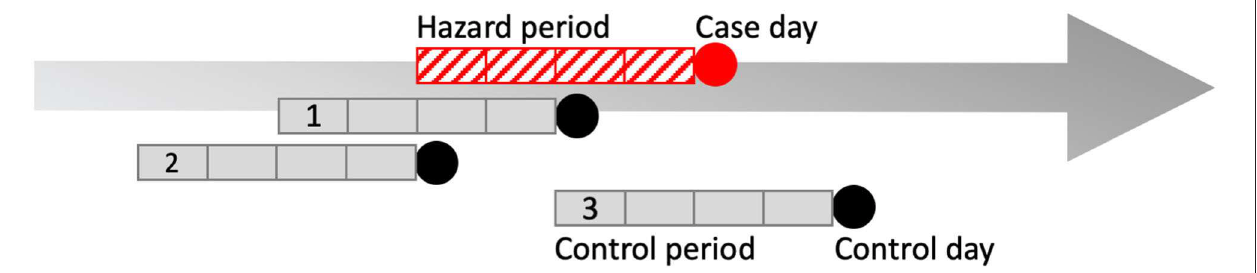
FIGURE 2 | Pictorial representation of one possible case and control period arrangement in a case-crossover design. Four-week hazard period (red hatched box). Case day (red circle), and three 4-week control periods (gray boxes) and control days (black circles) compose the data from one case. The case-crossover design is a type of observational study where each individual serves as its own control, i.e., they are “self-matched” (44). The case-crossover study design is used to estimate the odds ratio of an individual experiencing an acute “event” immediately following exposure to a hazard over a defined period (44). Because controls are self-matched, it means the individual also has the potential for exposure to the hazard during the control periods ( 44). In our study, the exposures were ambient pollutants and temperature over a 4-week hazard period immediately prior to presentation. The day that bronchoalveolar lavage fluid was obtained was selected as the case day. To control for day-of-week effect in the model, control days consisted of all days falling on the same day of the week and year as the case day, within 4-weeks of case day occurrence. For example, if a horse presented on a Monday, control days were three different Mondays within a 4-week period of the case day during the same year. Therefore, matched sets for one finding of increased proportions of lower airway granulocytes consisted of one case and three control periods as shown above, or any other combination of pattern so long as all control periods fit within 4 weeks of case occurrence. Another method used to reduce bias in the statistical model was that control periods were randomly directed, meaning that control periods could either precede, follow, or straddle the hazard period. This may seem counterintuitive but if an exposure during the control period were meaningful, the horse could have had mildly increased proportions of lower airway granulocytes identified on a day other than the case